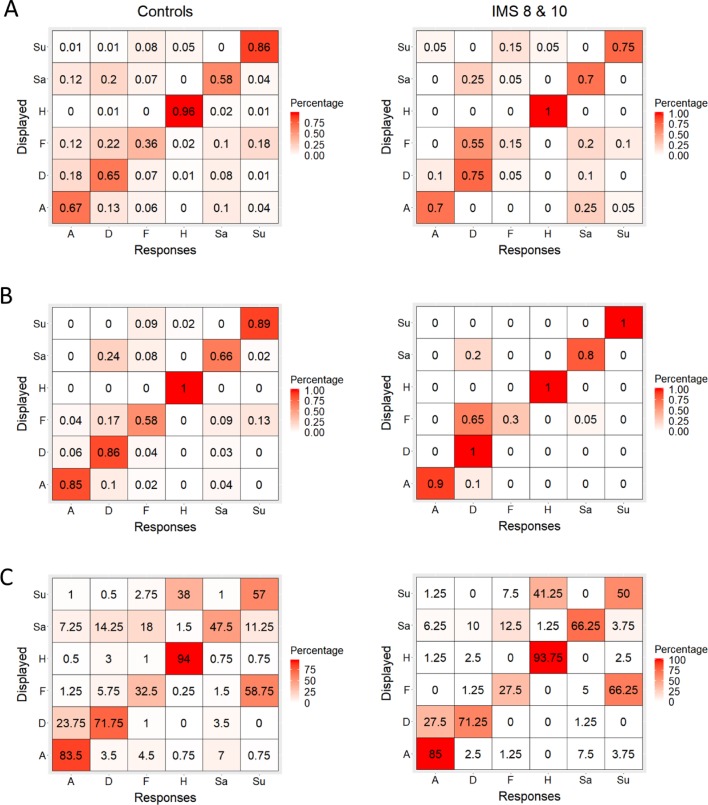
Confusion matrices.(A, B, C) Distribution of control participants’ (left) and IMS 8 and 10’s (right) percentage of trials in which they chose each of the six response alternatives when faced with the six displayed facial expressions in Experiment 1 (A), 2 (B), and 3 (C).